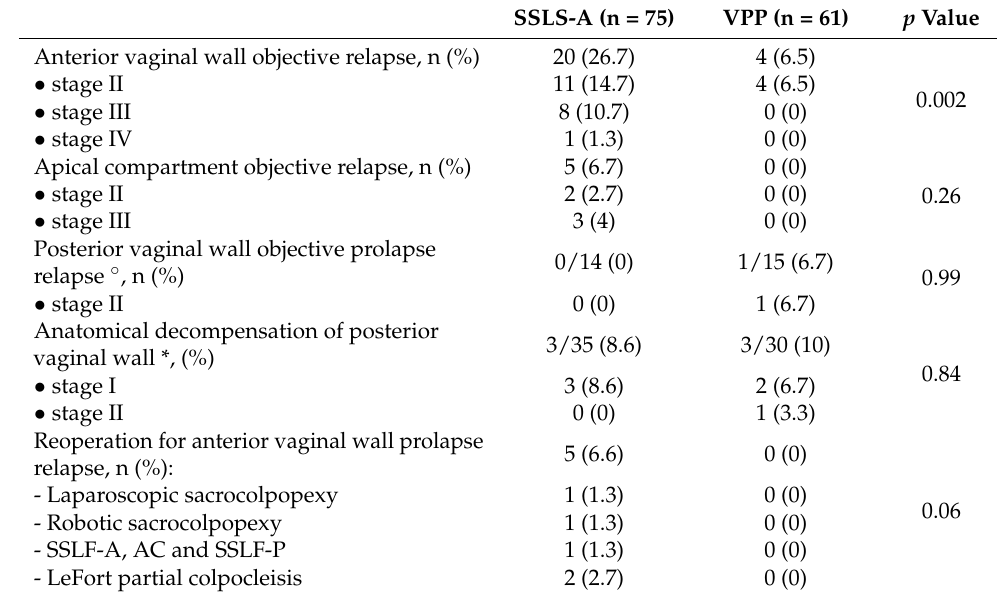
Table 5. Anatomical relapse and reoperation rate of the population during the study period. SSLS-A (n = 75) VPP (n = 61) p Value Anterior vaginal wall objective relapse, n